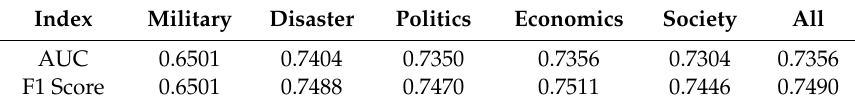
Table 3. AUC and F1 Scores for each category and all samples.